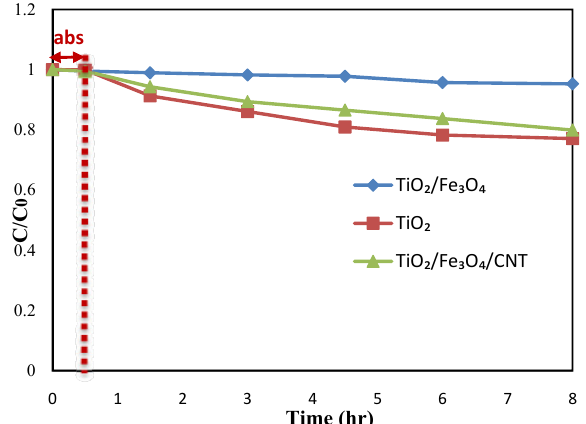
Fig. 14. Determination of methyl orange dye removal by TiO 2 and TiO 2 /Fe 3 O 4